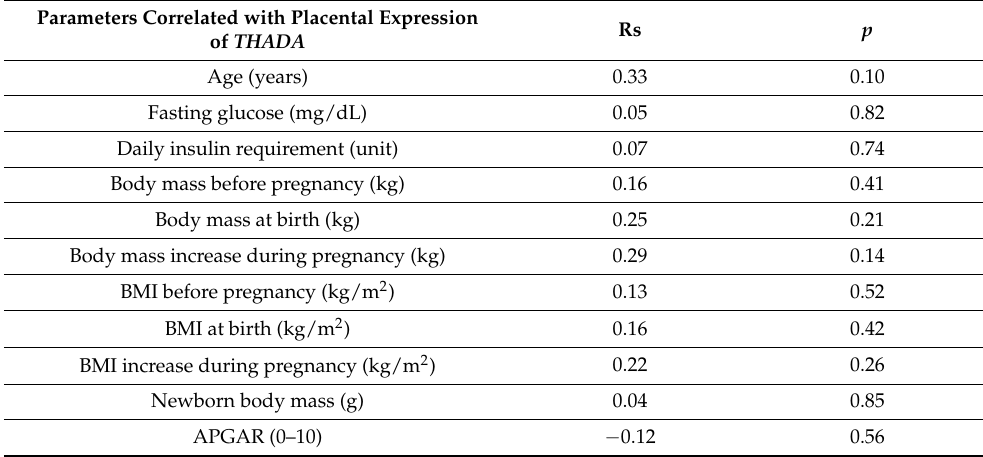
Table 5. Correlations between THADA expression in the placenta and clinical parameters in the GDM group